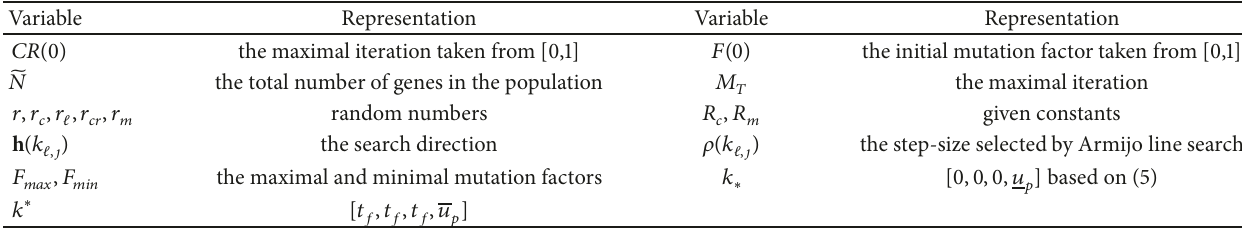
Table 1: Definitions of variables in Section 5.